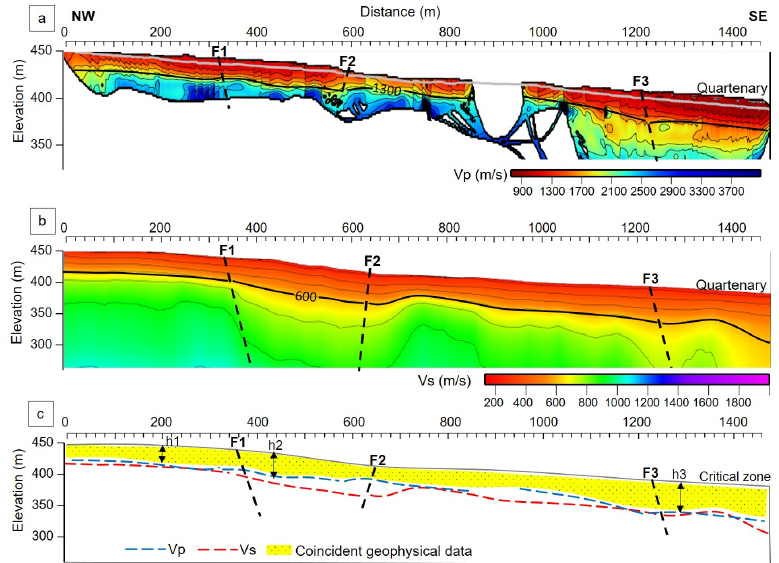
Figure 9. Geophysical imaging of La Salud South site with the interpretation proposed and details. ( a ) The Vp model from seismic tomography, ( b ) the Vs model from MASW, and ( c ) a joint comparison of the Vp and Vs results. The low velocity anomaly between F1 and F2 could correspond to the fault zone of the S-AMF.